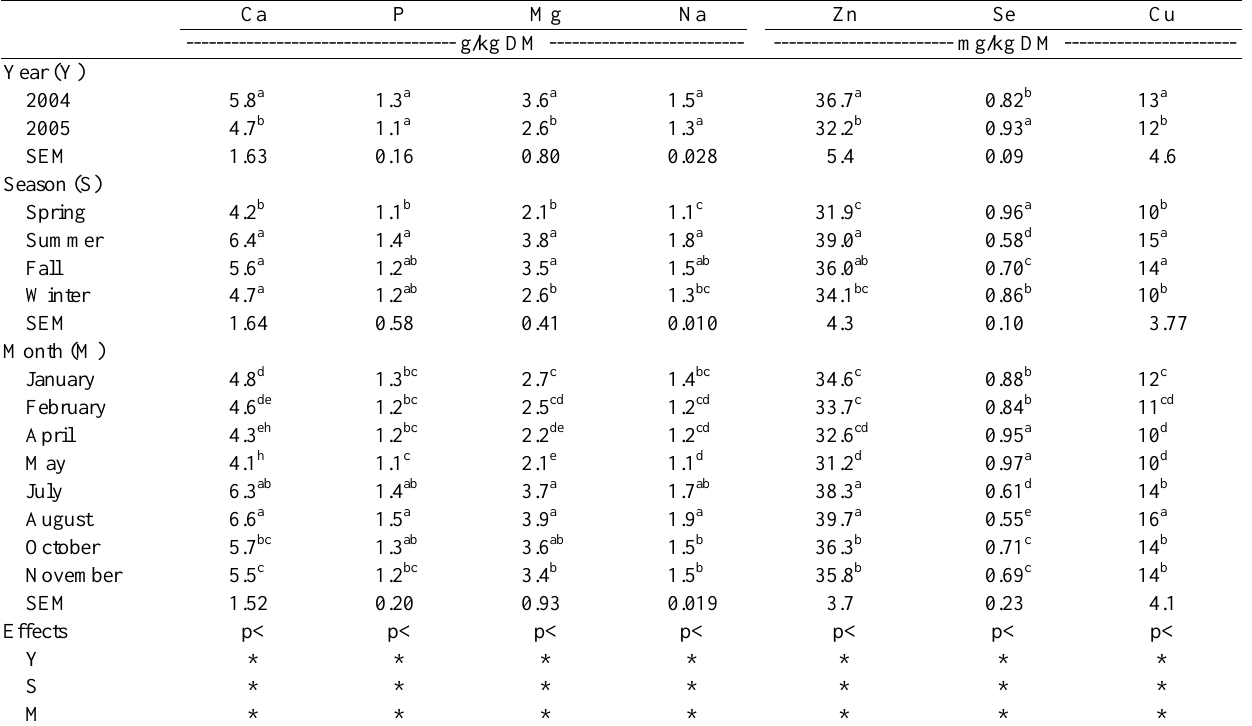
SEM = Standard error of mean. ** Table 2. Mineral content of the diet consumed by grazing steers Ca